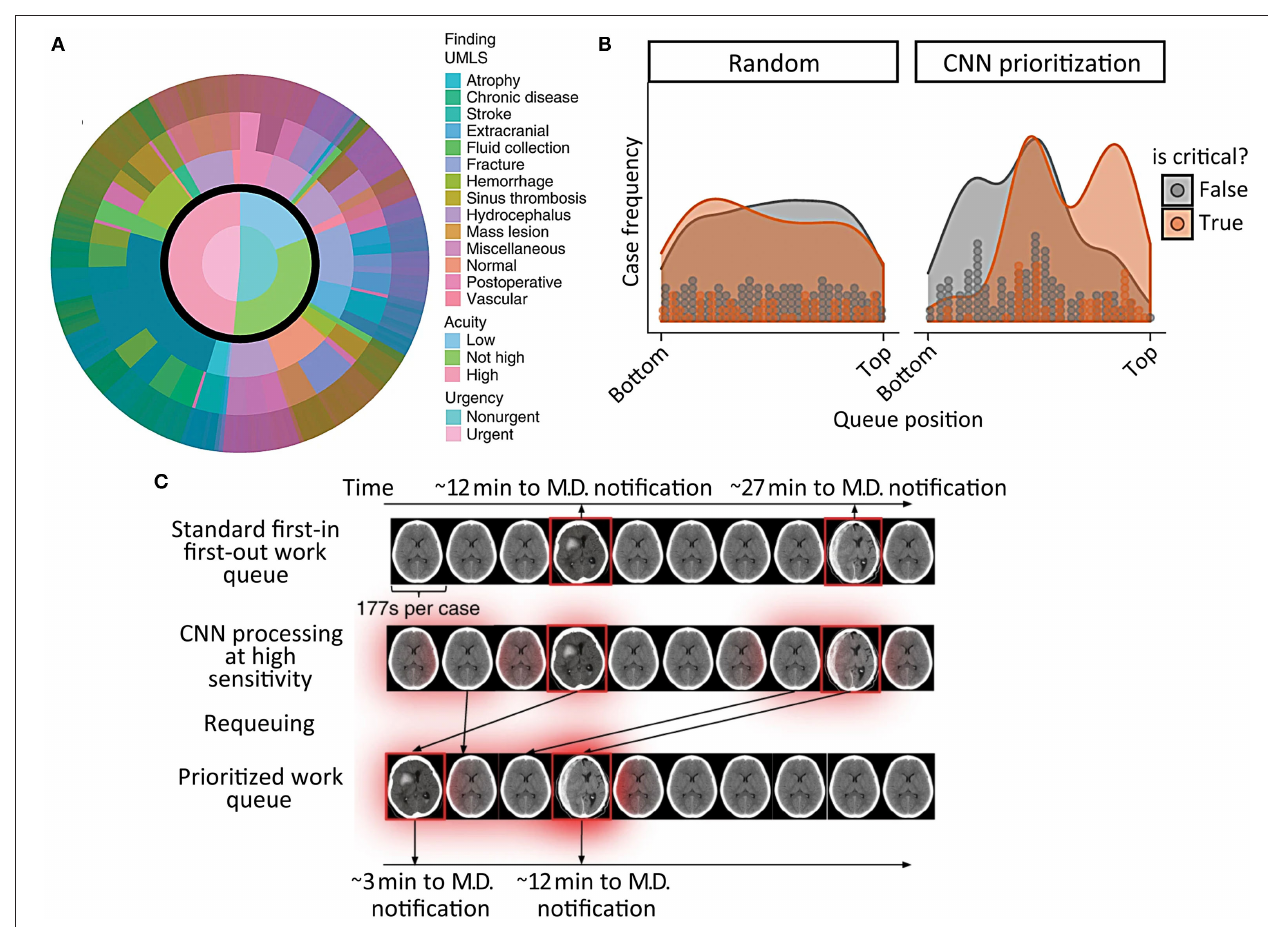
FIGURE 7 | Incorporation of a reprioritization, or triage, algorithm into the radiological workflow in acute TBI (24). (A) Illustrates the broad range of pathological findings represented in the head CT training data, and how they were classified into non-urgent and urgent categories. (B) Shows the typical order in which critical (orange) and non-critical (gray) head CT exams would be interpreted by a radiologist before (left graph) and after (right graph) reprioritization by a deep learning algorithm. The gray and orange dots represent discrete CT exams, while the shaded regions are the smoothed exam frequency distributions. (C) Is a schematic representation of the algorithm’s prioritization